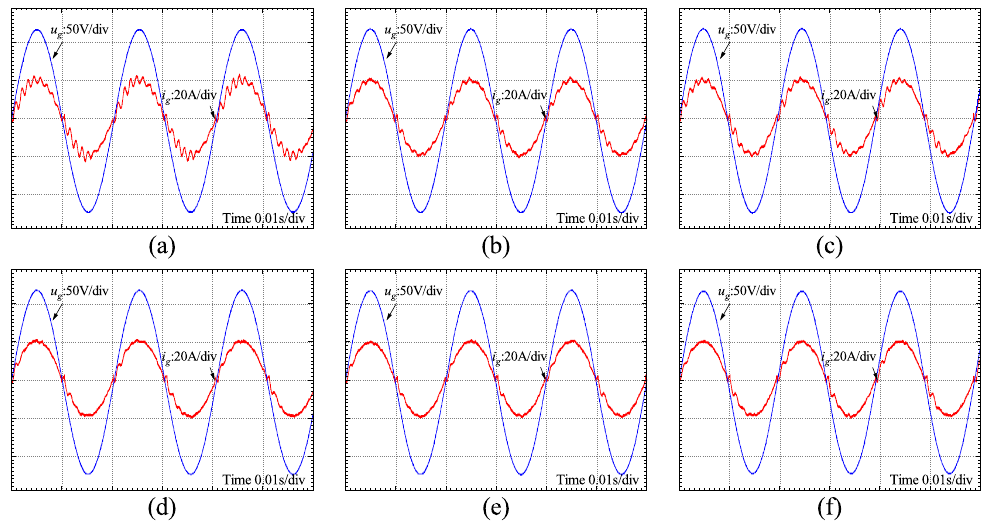
Figure 21. The waveform of grid voltage u g and grid current i g when C f varies to 8 µ F. ( a – c ): using FIR filters when the grid frequency is 49 Hz, 50 Hz, and 51 Hz. ( d – f ): using IIR filters when the grid frequency is 49 Hz, 50 Hz, and 51 Hz.